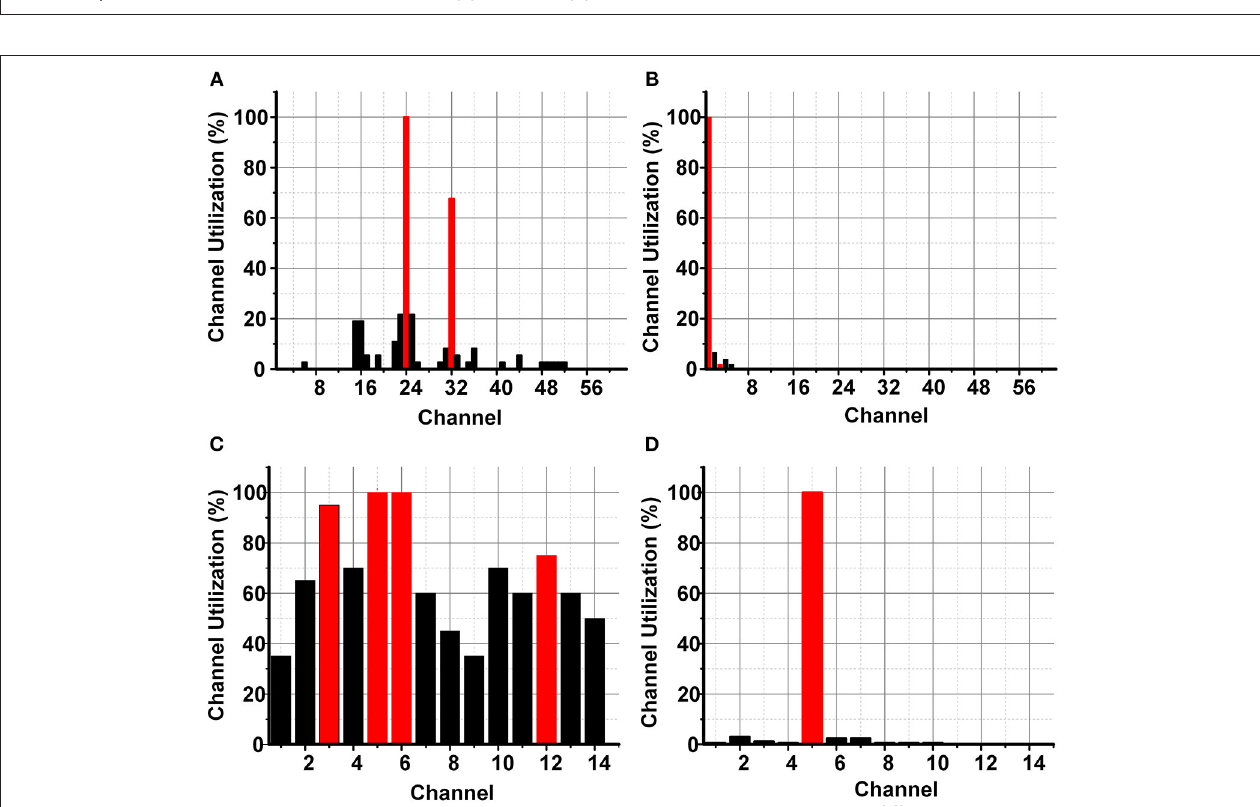
FIGURE 8 | Channel importance for SEED data set using (A) SKB, and (B) SFS, and DREAMER data set using (C) SKB and (D) SFS.